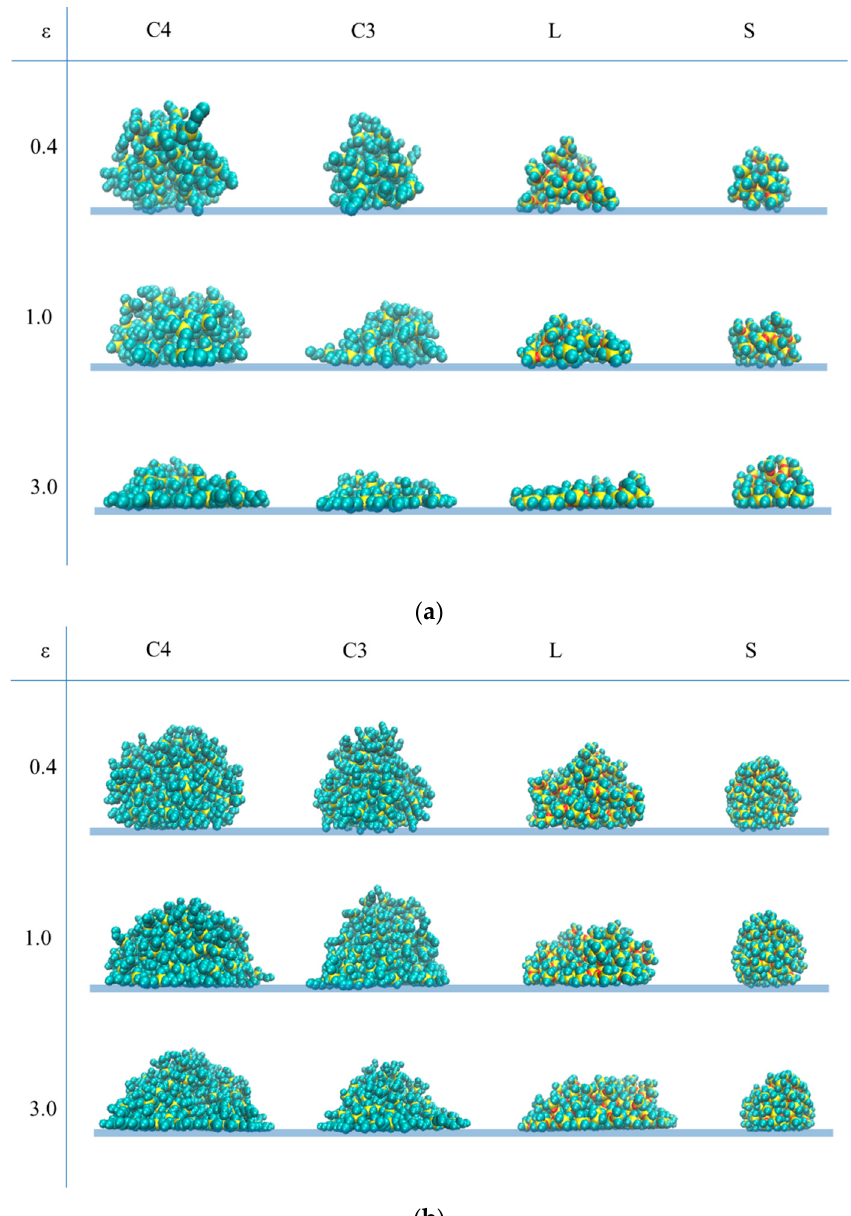
Figure 8. Snapshots of dendrimer conformations (side view) at various values of the adsorption parameter ε for ( a ) the fourth generation and ( b ) the sixth generation of the carbosilane and siloxane dendrimers under study. The yellow beads correspond to Si atoms, red beads correspond to O atoms, and cyan beads show united C atoms.